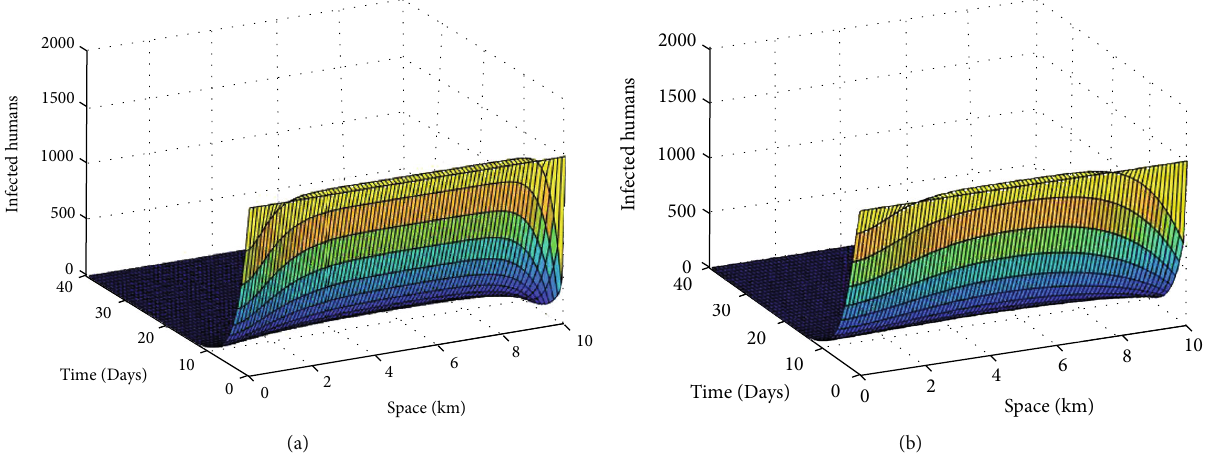
= 0 : 1 km day − 1 , and 3